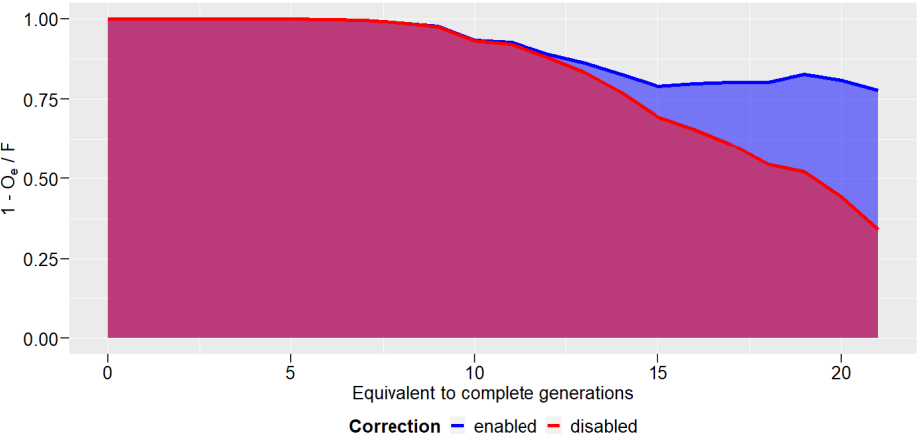
Figure 3. Expressed opportunity of